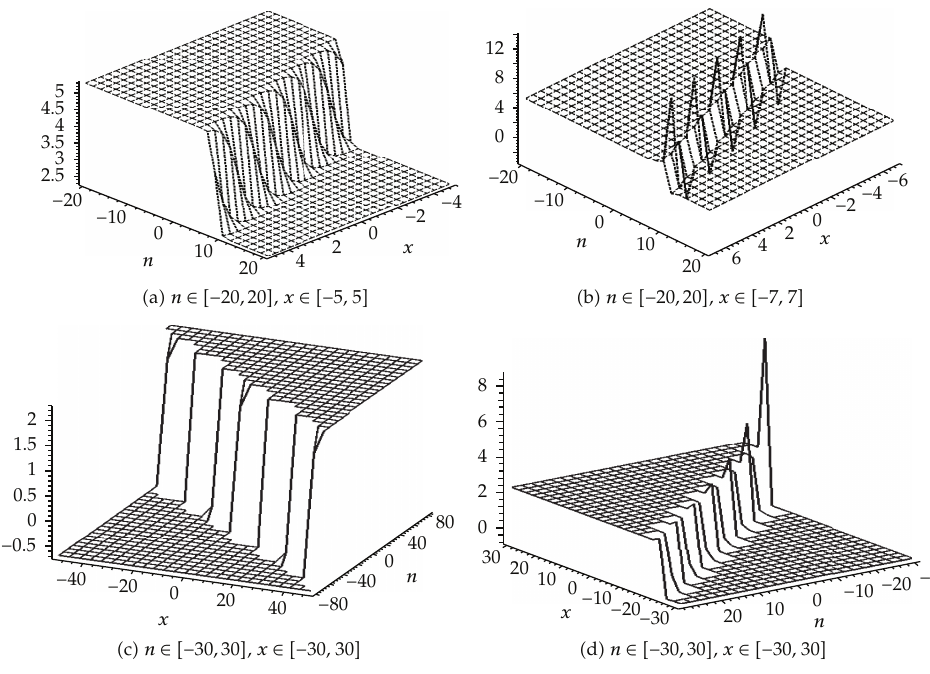
Figure 1: The solutions u n in (cid:2) 3.10 (cid:4) and (cid:2) 3.11 (cid:4) show four shapes of discrete kink and antikink solitons for fixed parametric values of a 0 ,a 1 ,α,β,γ 0 , t and di ff erent kinds of C values: (cid:2) a (cid:4) C (cid:8) 4 > 0; (cid:2) b (cid:4) C (cid:8) − 4 < 0; (cid:2) c (cid:4) C (cid:8) 1 . 4 > 0; (cid:2) d (cid:4) C (cid:8) − 1 . 4 <